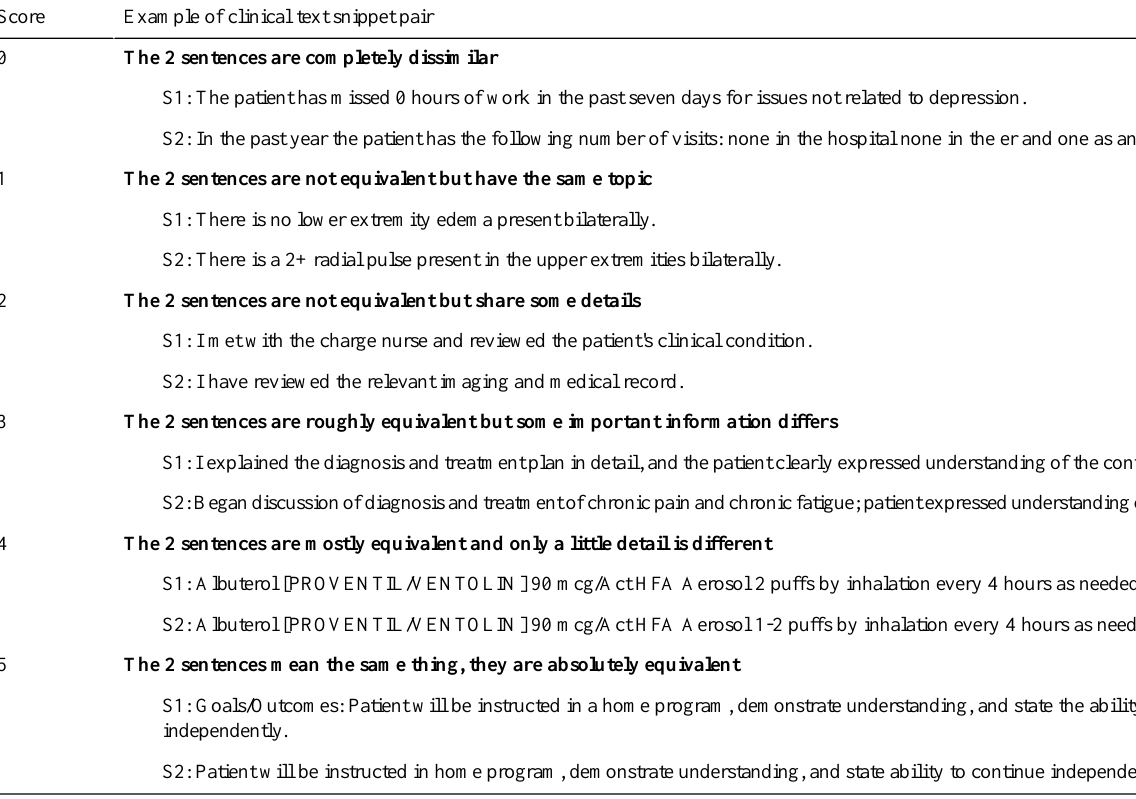
Table 1. Examples of ClinicalSTS a . Example of clinical text snippet pairScore